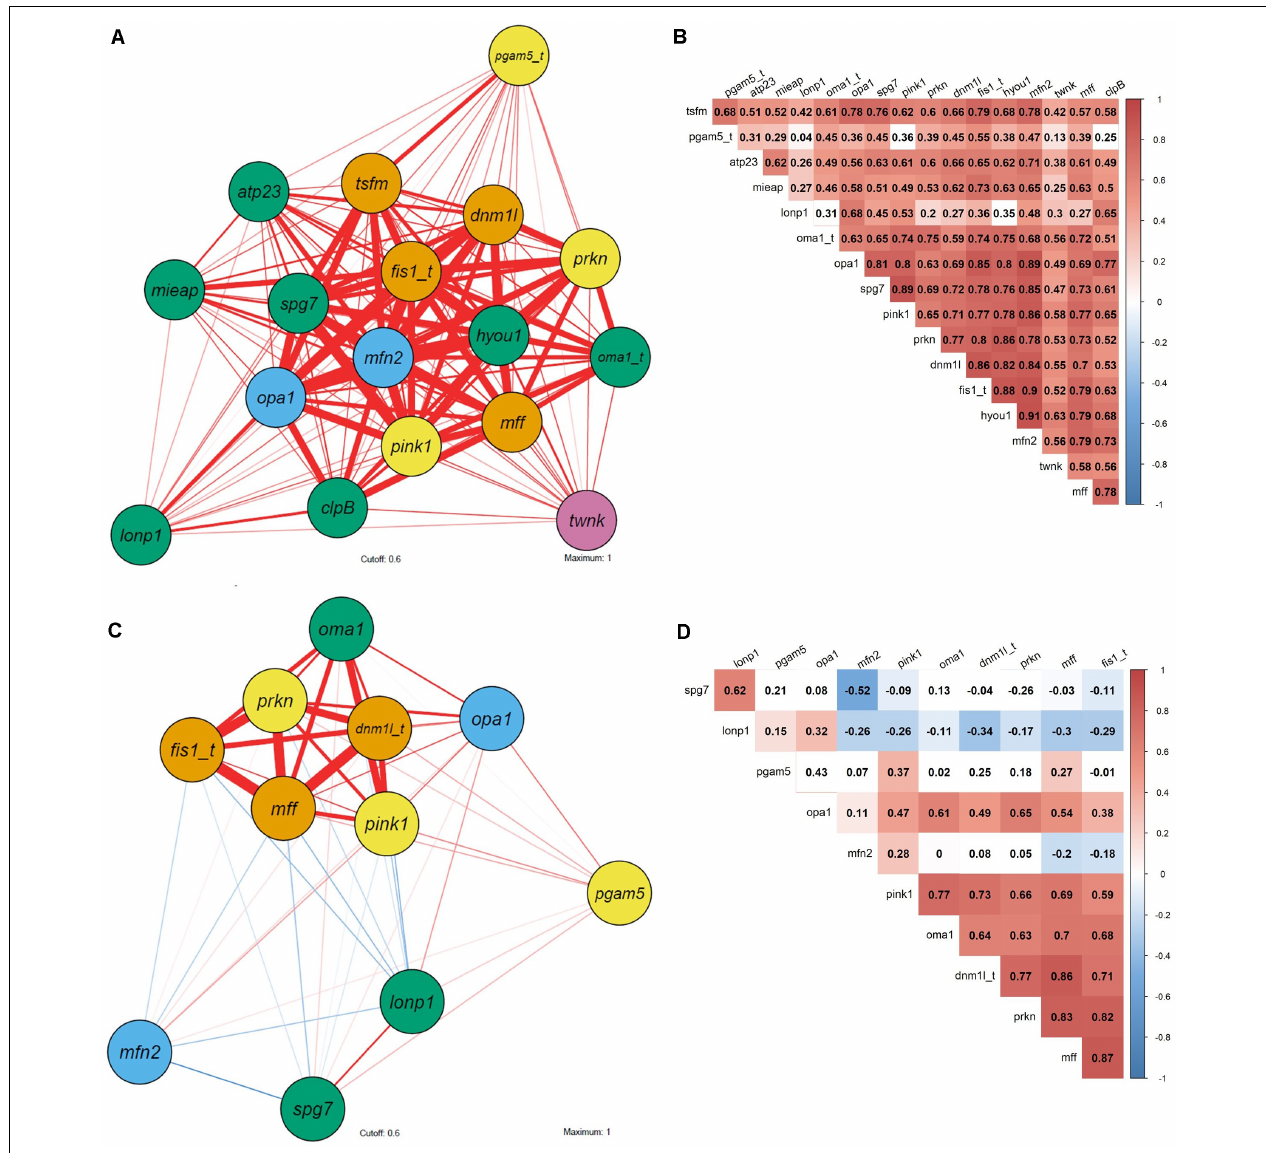
FIGURE 7 | Correlation network and corresponding heatmap of biomarker expression in C. gigas and M. edulis in response to H/R stress. (A,B) C. gigas ; (C,D) M. edulis ; (A,C) correlation network; (B,D) heatmap. Functional gene groups: orange, mitochondrial fission; light blue, mitochondrial fusion; green, mitochondrial quality control and proteolysis; yellow, mitophagy; pink, mtDNA maintenance. Pearson correlation coefficient: red, positive correlation; blue, negative correlation. Correlation networks are based on Pearson’s correlation with a cutoff of 0.6 and maximum of 1. Non-colored fields of heatmaps and thin shaped correlation network represent non-statistical significant correlations. Thickness of lines represent statistically significant correlations ( p < 0.05). Underlying Pearson correlation coefficient are depicted in associated heatmap. Gene name with appended “t” depicts transformed data to ensure normal